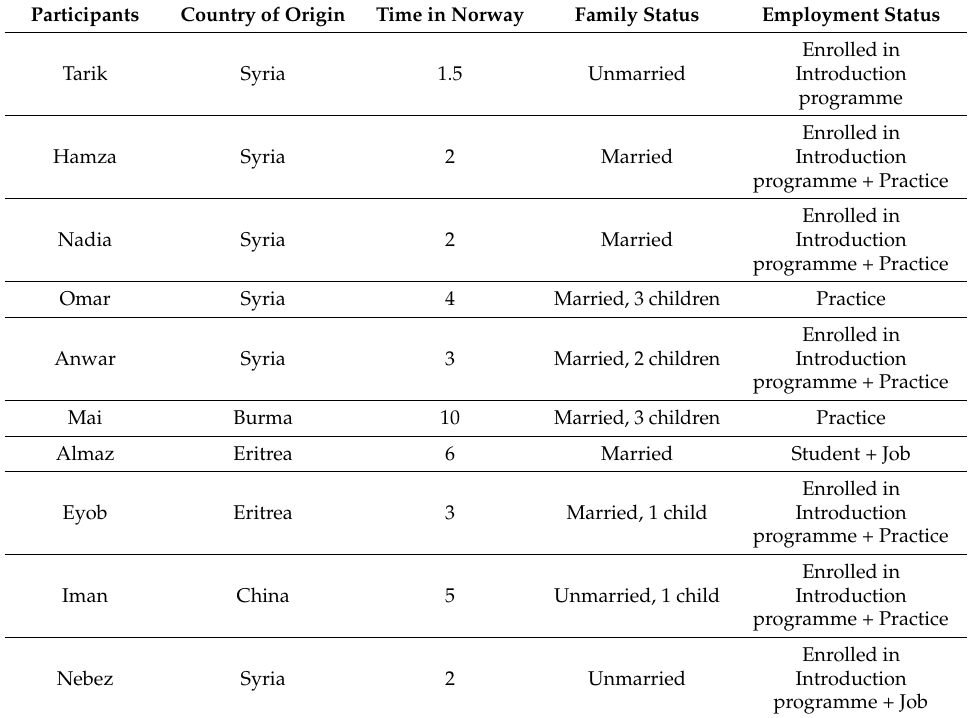
Table 1. Presentation of